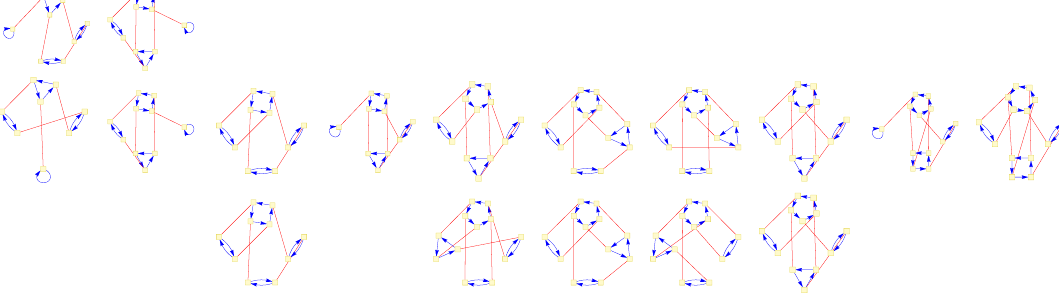
Figure 18 . Part of the skeleton-reduced diagrams of ( G 4 ) connected (6 ; 4 ; 2 ; 2). There are 28 diagrams in total.